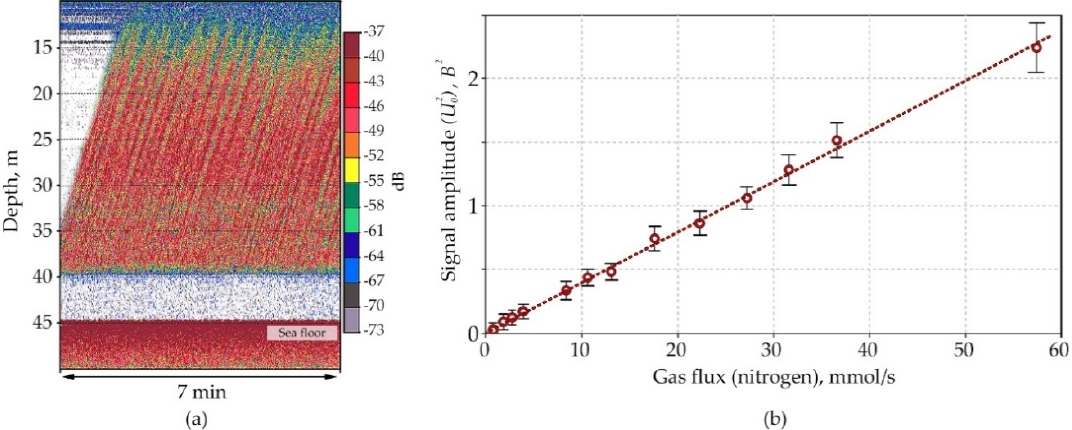
Figure 4. Sonar cross-section of an engineered seep detected during calibration ( a ); calibration curve of signal amplitude vs. bubble gas flux ( b ).